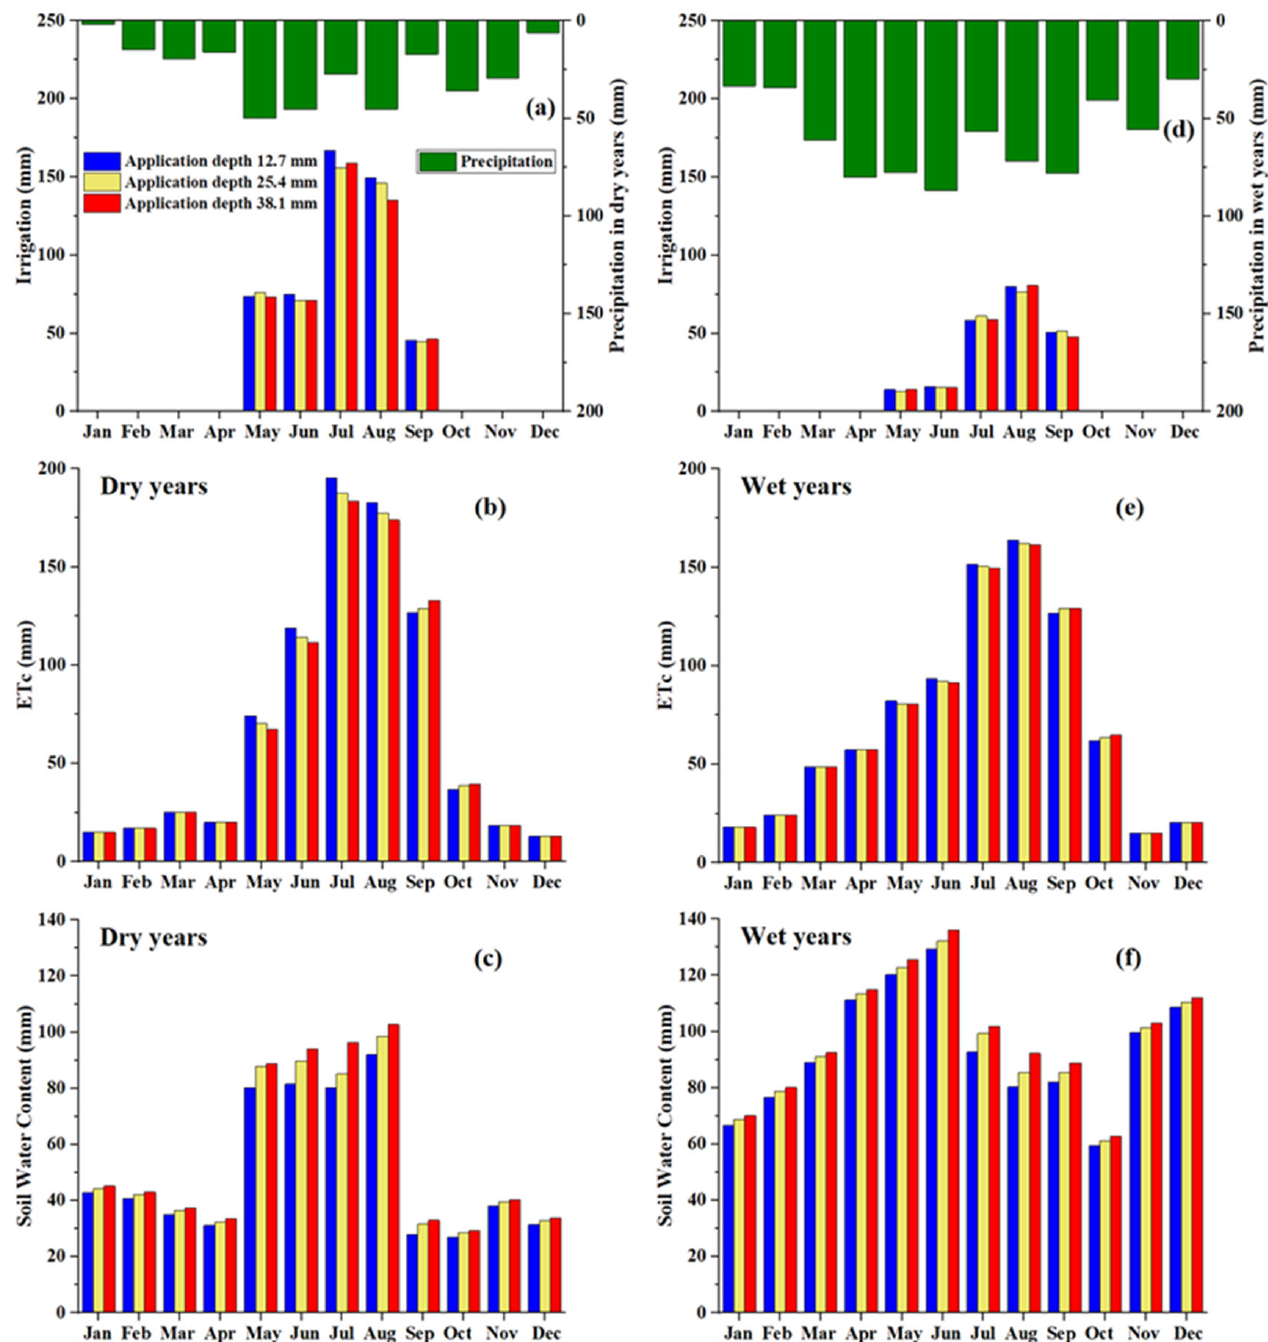
Figure 3 . Comparison of average monthly irrigation ( a , d ), crop evapotranspiration (ET c ) ( b , e ), and soil water content ( c , f ) during dry and wet years using different irrigation application depths in the irrigated cotton HRUs in the Double Mountain Fork Brazos basin.